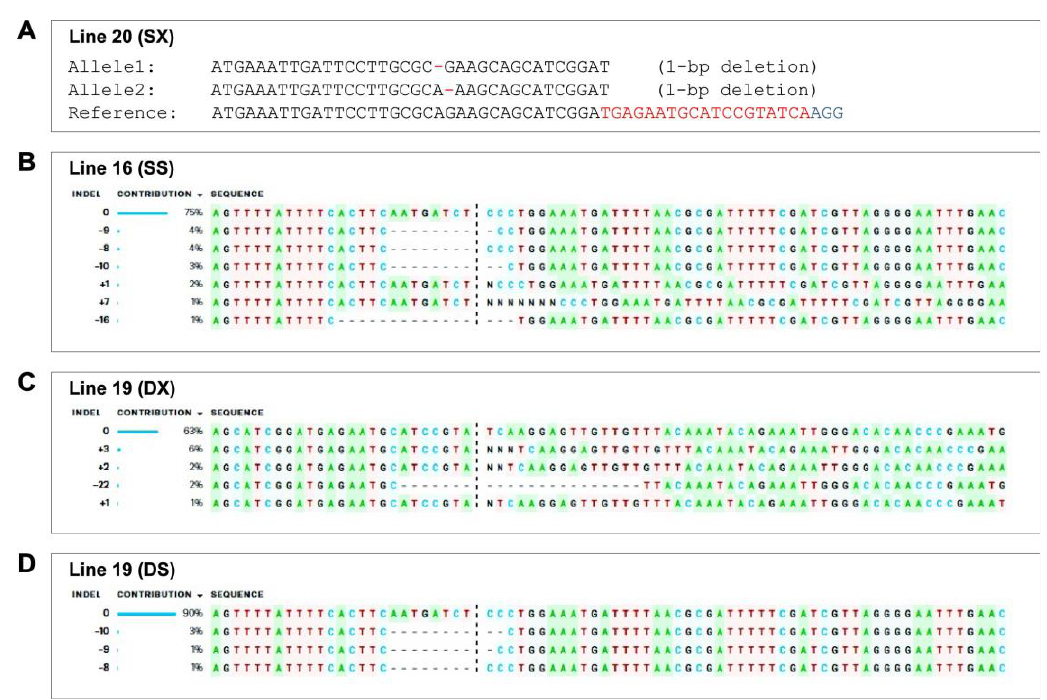
Figure 4. Single and dual-gene DXS editing confirmation in tomato cv. AV at GE 0 generation. ( A ) Single-gene editing of SX-line 20 and SS-line 16 ( B ). ( C ) Dual-gene (DXS) line 19 editing of XSP10 (DX) and SlSAMT (DS) ( D ); dashes represent deletions and N represents insertion at the guide RNA region. DS Decode M and ICE-Synthego software were used for decoding the PCR products. (+0) represents the WT. The sequencing chromatogram peaks of complicated chimeric plants with more than 2 editing events were unable to decode with DSDecode M software and were particularly analyzed with ICE-Synthego